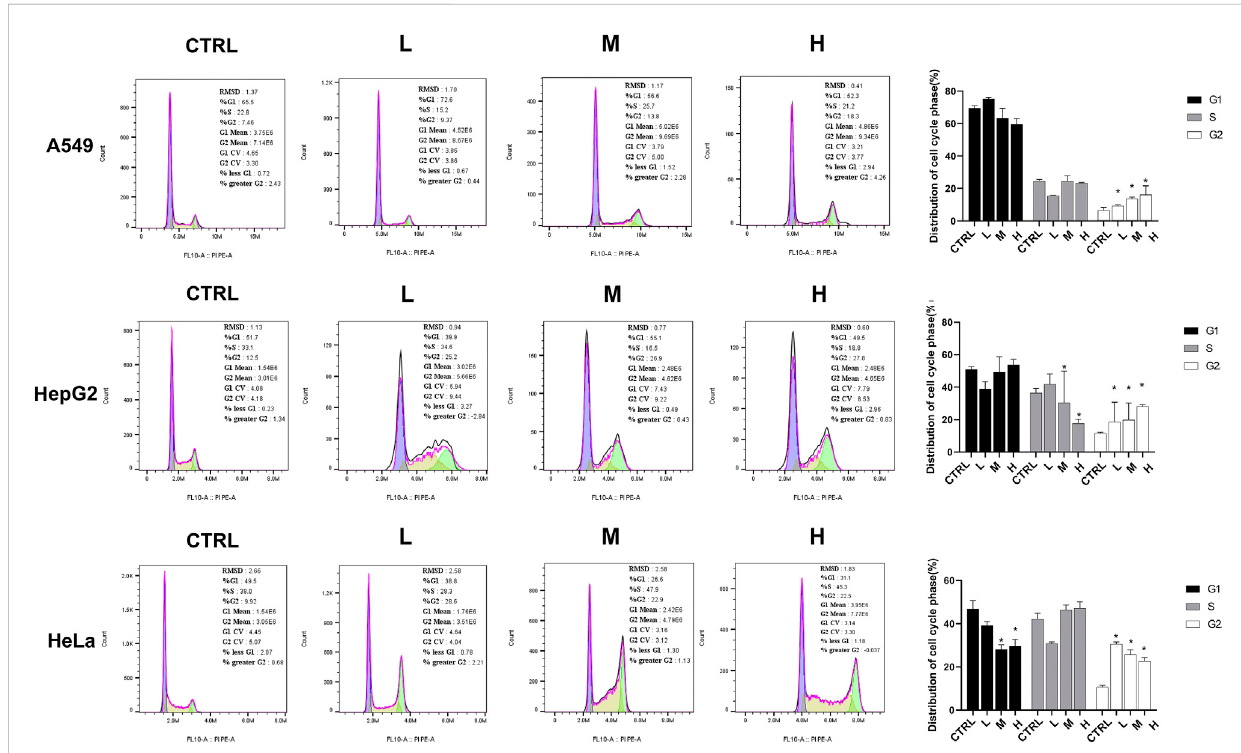
FIGURE 10 CRincreasedcancercellsattheG2/MphaseandimpededthetransitionfromG2toMphase.A549,HepG2,andHeLacellsweretreatedwithCRfor 24 h and harvested for PI-staining and fl ow cytometric analysis. *, p < 0.05 vs. CTRL.